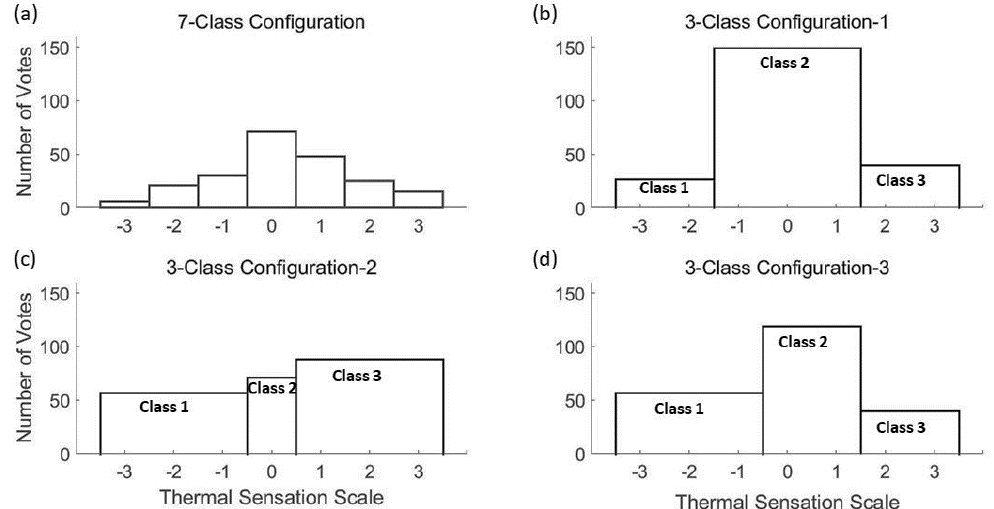
Figure 7. ( a ) A histogram of 7-class thermal sensation scale of ASHRAE system. ( b ) A histogram of 3-class thermal sensation of Configuration 1. ( c ) A histogram of 3-class thermal sensation of Configuration 2. ( d ) A histogram of 3-class of Configuration 3.